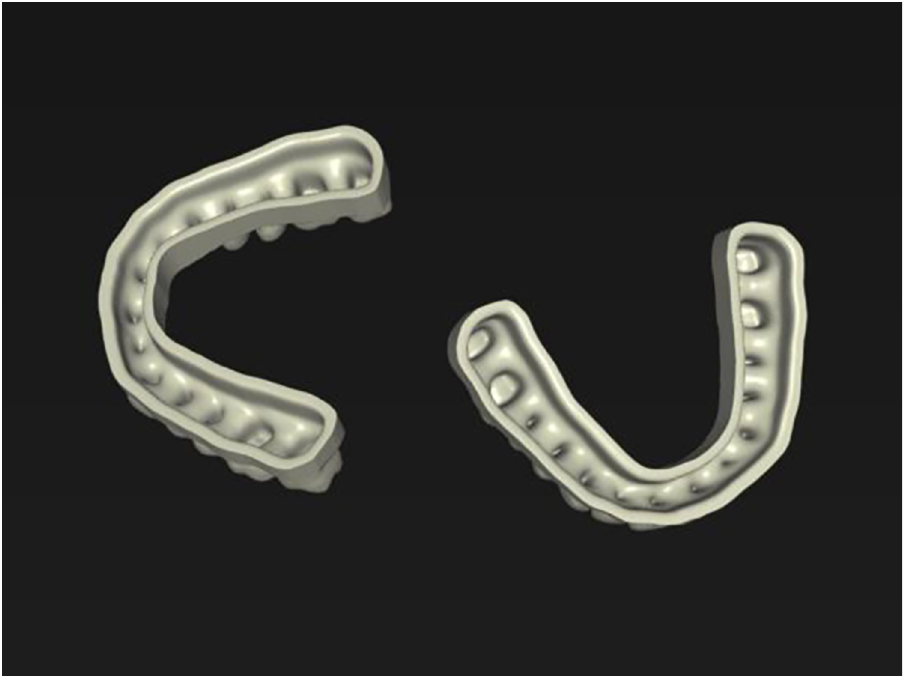
Fig 2. Hollowed bases of two